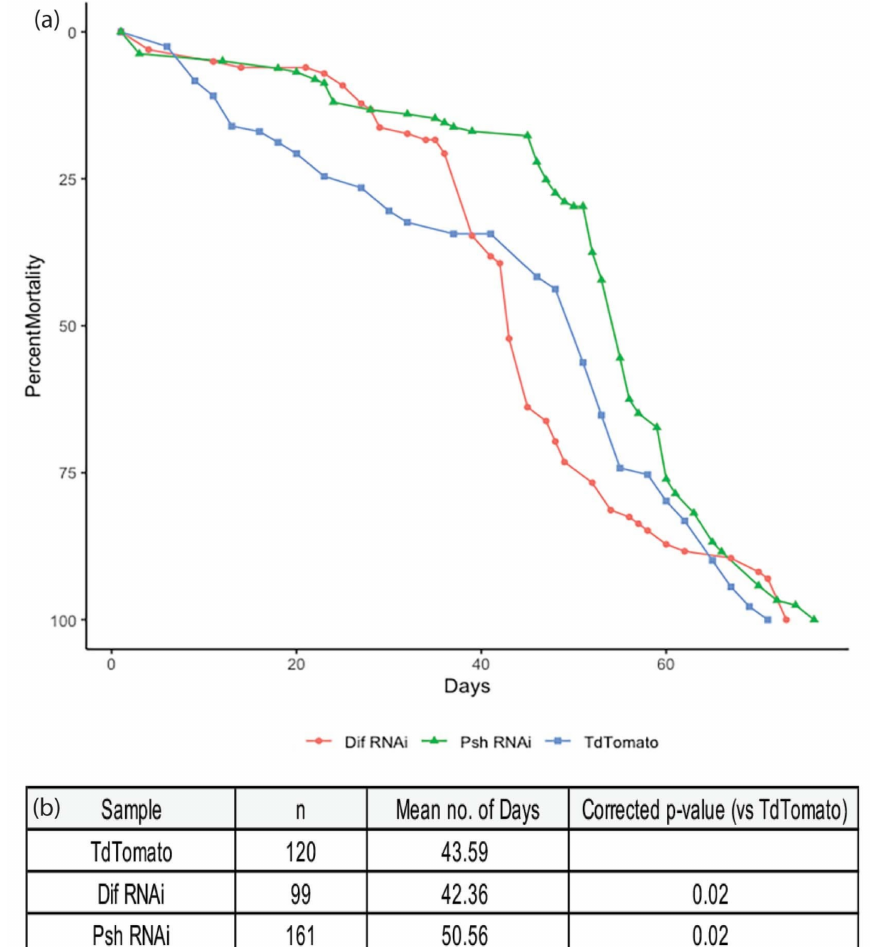
Figure 7. Knockdown of persephone extends lifespan. Lifespan analysis of TdTomato (control), psh-RNAi and Dif-RNAi in the whole fly. Genotype: TdTomato—Arm-Gal4 > UAS-Td-Tomato; Dif RNAi—ArmGal4 > UAS-Dif RNAi; Psh RNAi—Arm-Gal4 > UAS-Psh RNAi. ( a ) The lifespan curves for the various genotypes, and ( b ) table showing the number of subjects with mean lifespans and p -values. Raw data provided in Supplemental Table